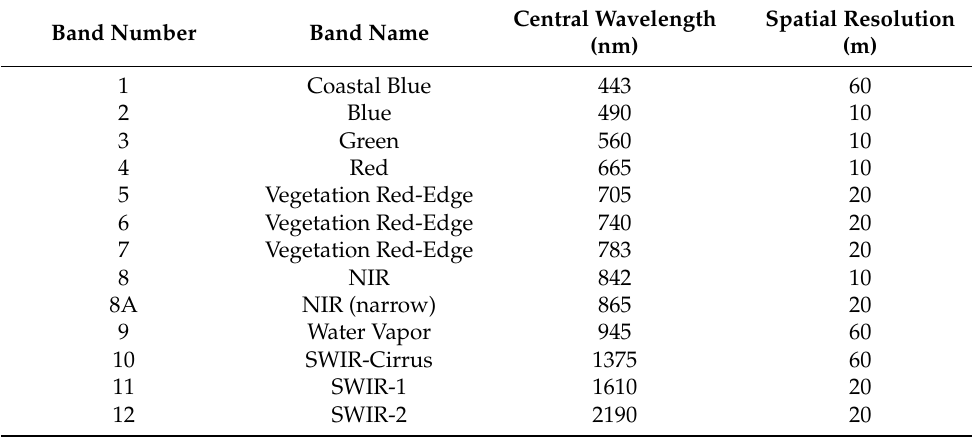
Table 1. Technical specifications of Sentinel-2